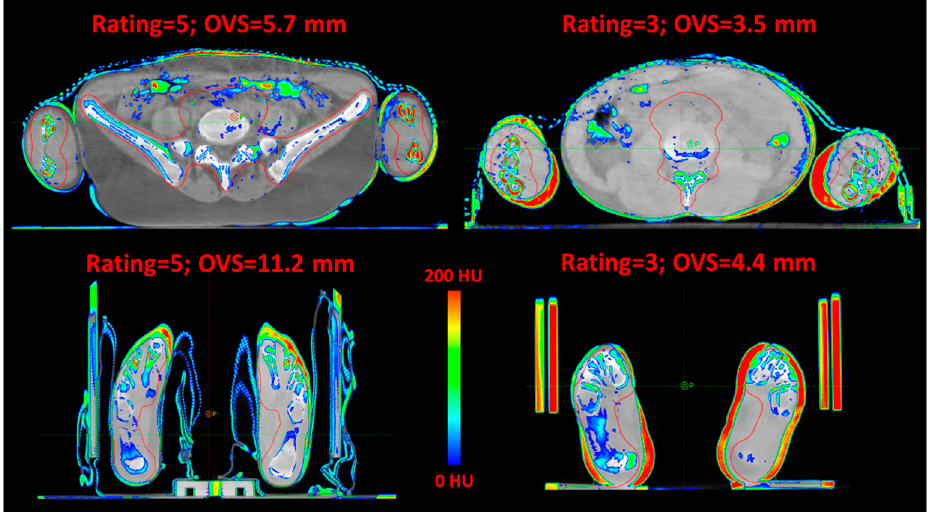
Figure 3. Four representative CBCT-CT matchings of upper and lower extremities. Color wash was used to highlight differences > 200 HU. The qualitative rating and OVS are reported. OVS = online vector shift.